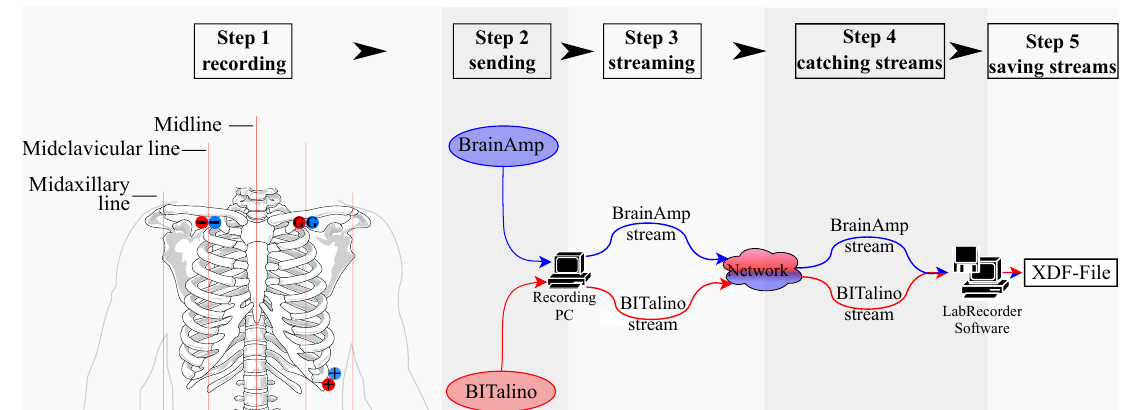
Figure 1. The left side of the image shows the adopted placement of electrodes. The BITalino leads are depicted in red and the BrainAmp leads in blue: − , below right clavicular; +, left side of chest midclavicular line beneath last rib; G, below left clavicular. The right side of the image shows the data acquisition workflow used for recording.